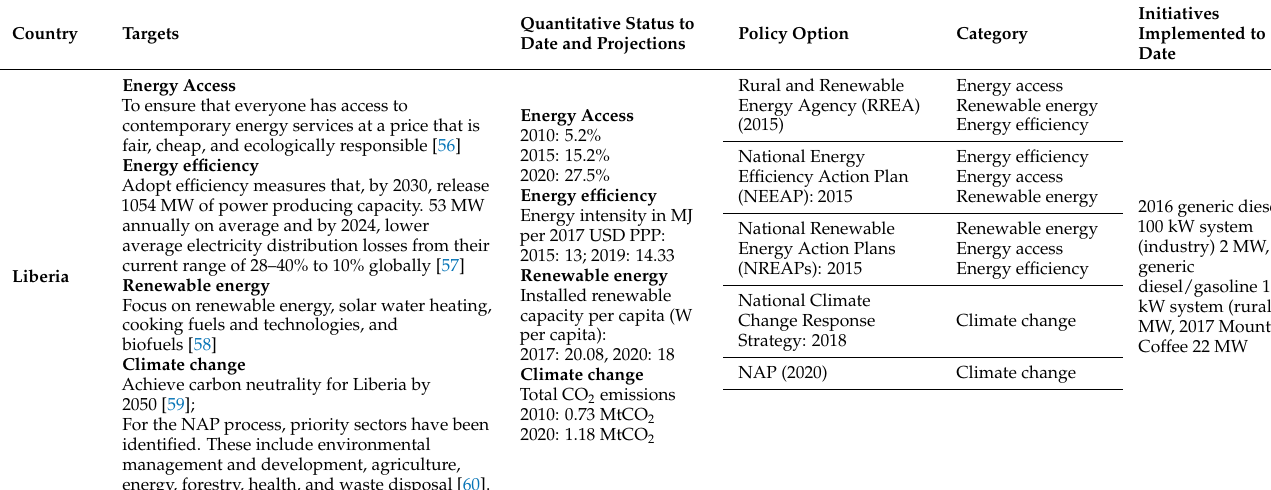
Table 9. Liberia (data from [22–24]).